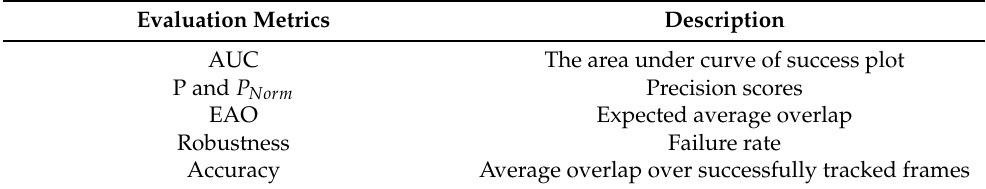
Figure 10. Normalized precision plots of OPE on LaSOT. The abscissa is the location error threshold, and the ordinate is precision. Table 3. The table for evaluation